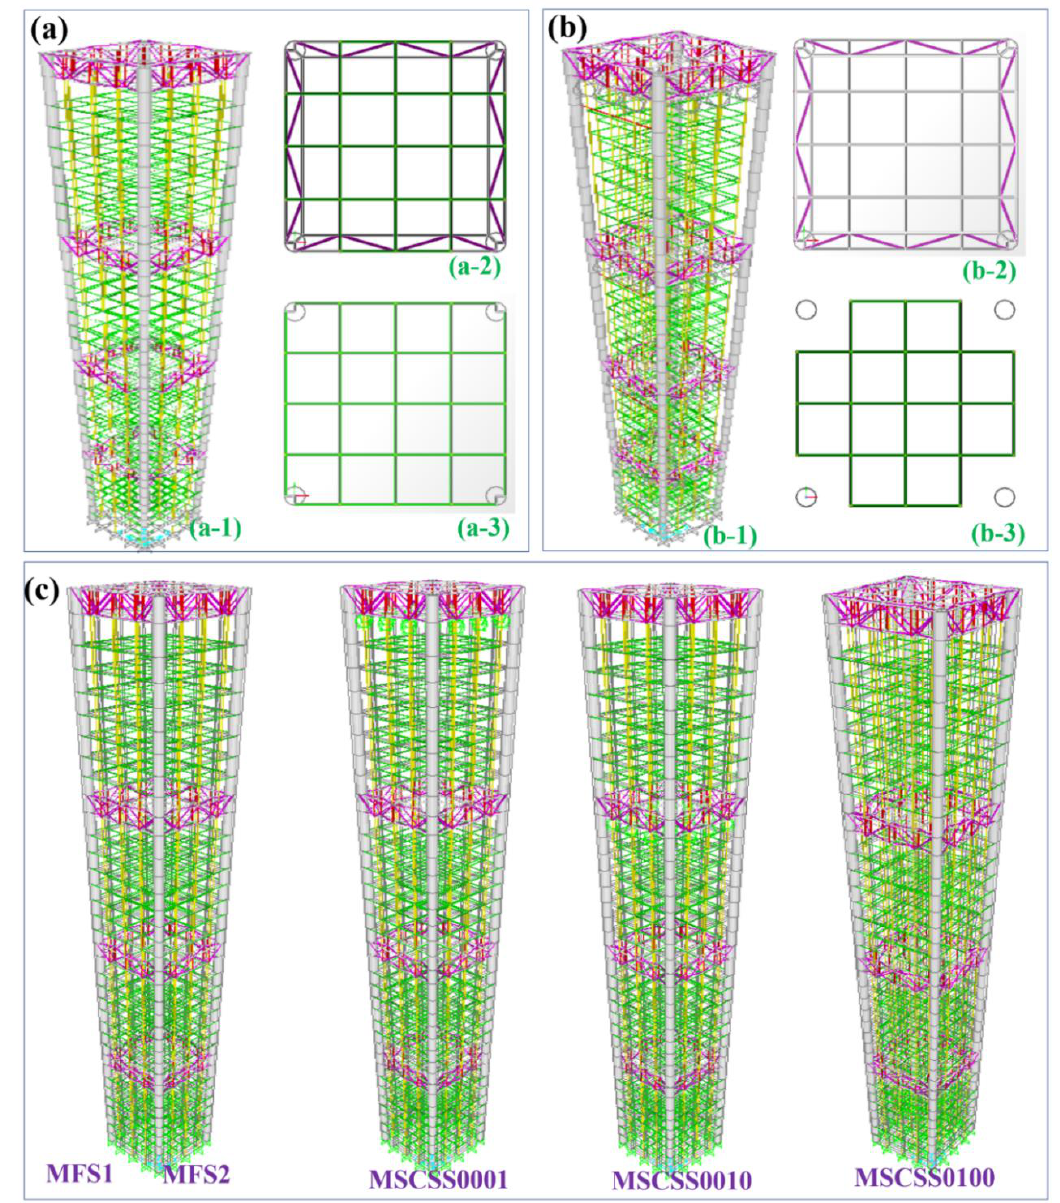
Figure 1. The geometry of designed steel MSCSS configurations. ( a ) The traditional megaframe structure (MFS) together with top views of the megaframe and the subframe; ( b ) the MSCSS together with top views of the megaframe and the optimized subframe; ( c ) the designed MSCSS configurations referring to the classical MFS ones.